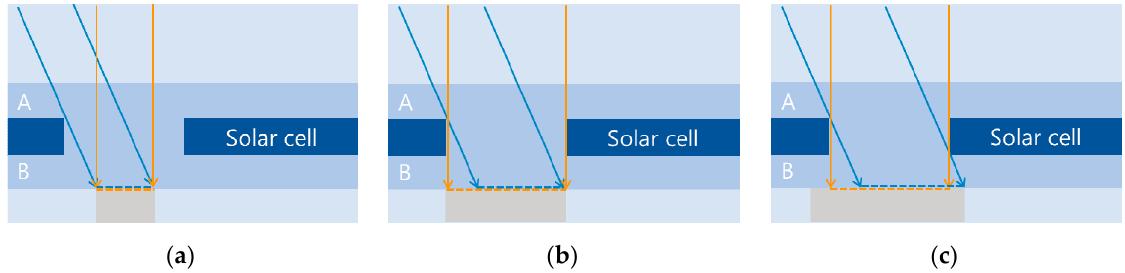
Figure 12. Illuminated and reflecting areas for two different incident angles (yellow: 0 ◦ , blue: 60 ◦ ): the width of the coated backsheet area is ( a ) smaller than cell distance; ( b ) identical to cell distance; ( c ) larger than cell distance.